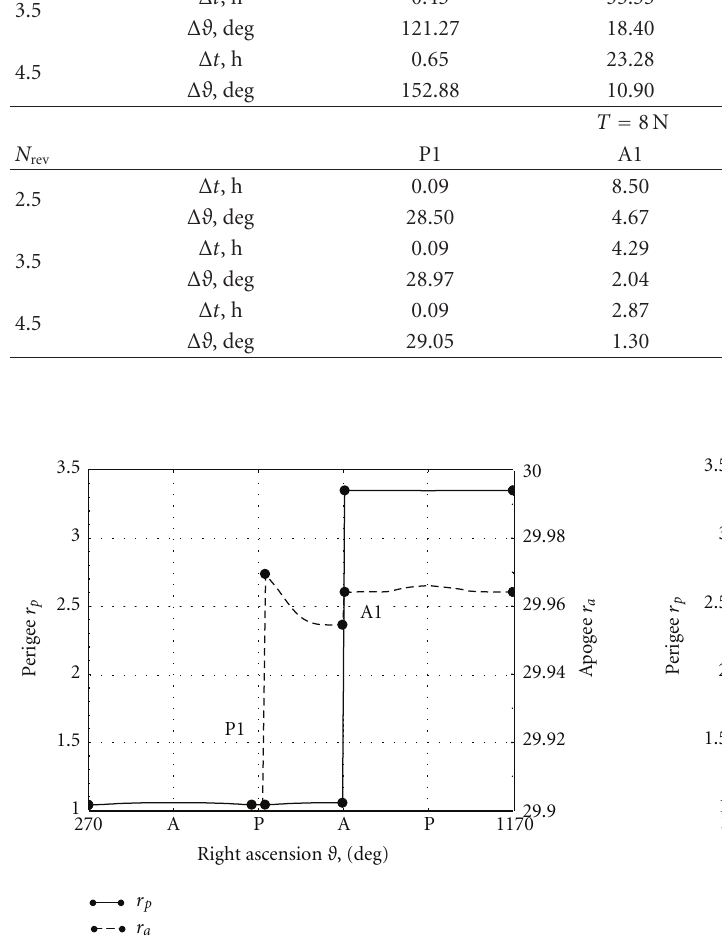
Figure 5: Perigee and apogee evolution for the 4.5-revolution 8N transfer (J2